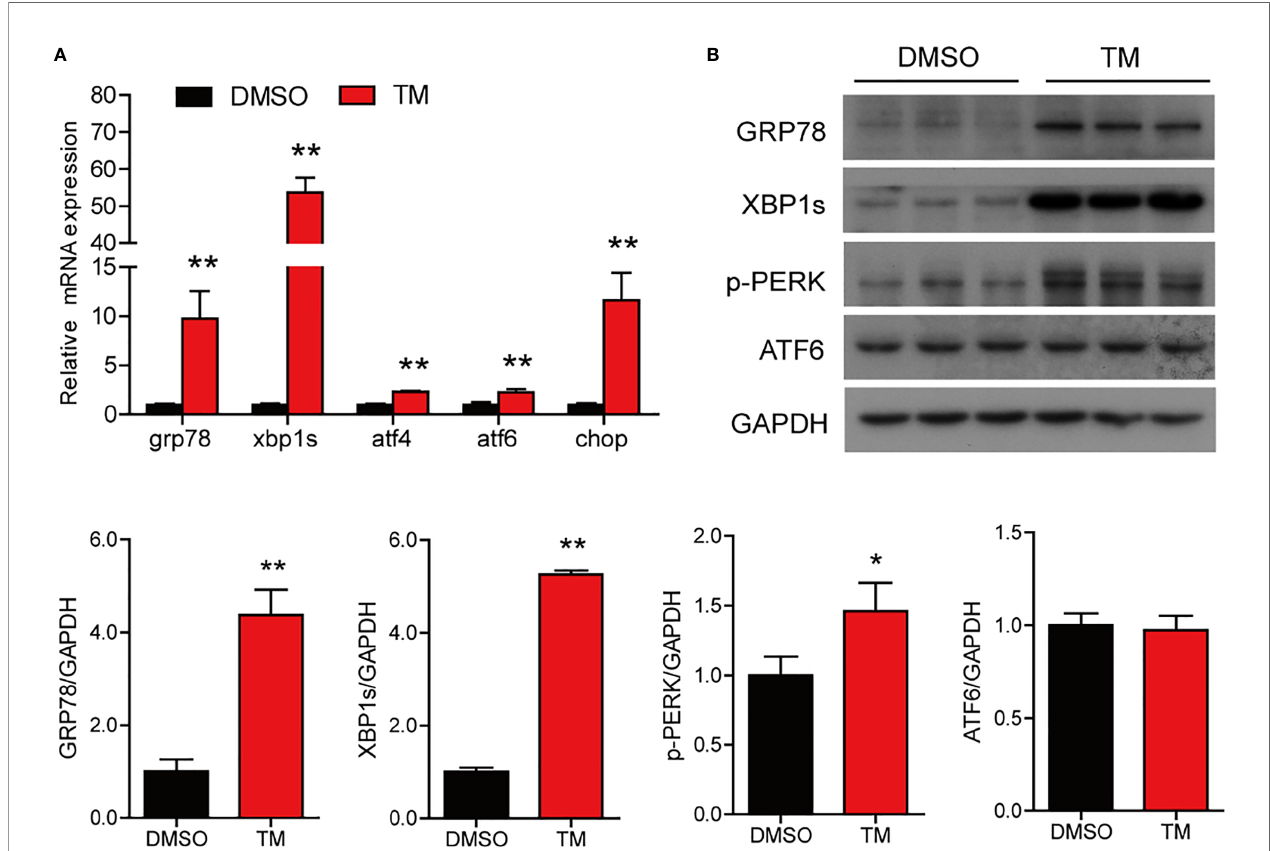
FIGURE 4 | TM treatment induces ER stress in the isolated intestinal cells of large yellow croaker in vitro . (A) Relative mRNA expression of ER stress-related genes in the isolated intestinal cells of large yellow croaker after TM treatment for 6 h (n = 3). (B) Western blot analysis of GRP78, XBP1s, p-PERK, and ATF6 protein levels in the isolated intestinal cells of large yellow croaker after TM treatment for 6 h (normalized to GAPDH, n = 3). grp78 , glucose related protein 78; xbp1 , X-box binding protein 1; atf4 , activating transcription factor 4; atf6 , activating transcription factor 6; chop , C/EBP homologous protein; PERK, double-stranded RNA-dependent protein kinase-like ER kinase; GAPDH, glyceraldehyde-3-phosphate dehydrogenase. Results were analyzed using independent t -test (* P < 0.05, ** P < 0.01), and they were presented as mean ± standard